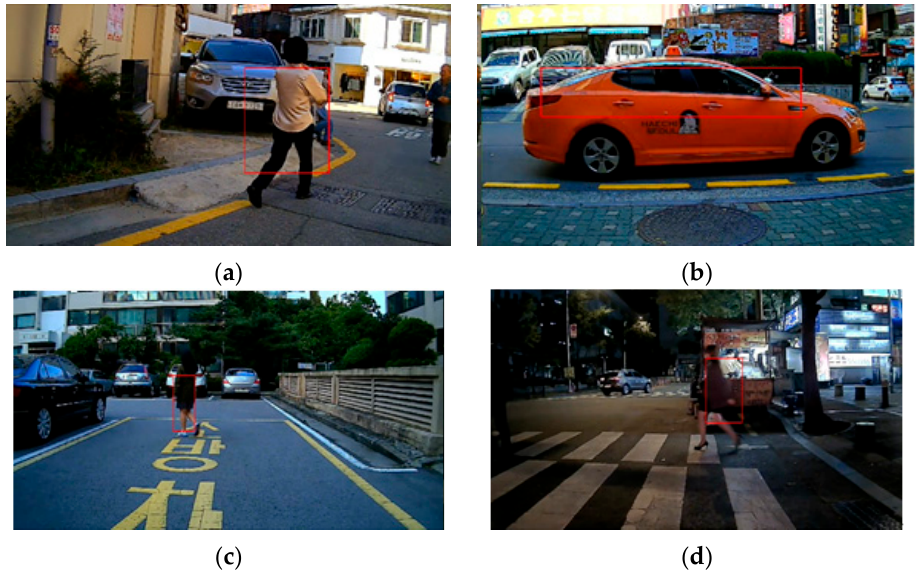
Figure 7. Part of detection results from the test vehicle. Tests were conducted in several places and under various conditions such as ( b,c ) parking lots and ( a,d ), streets ranging from ( a , c ) daytime to ( d ) dusk. All 19 videos including the above four were taken while the vehicle was in backwards motion. Table 2. False positive and negative results on the all 19 videos (150 frames each).